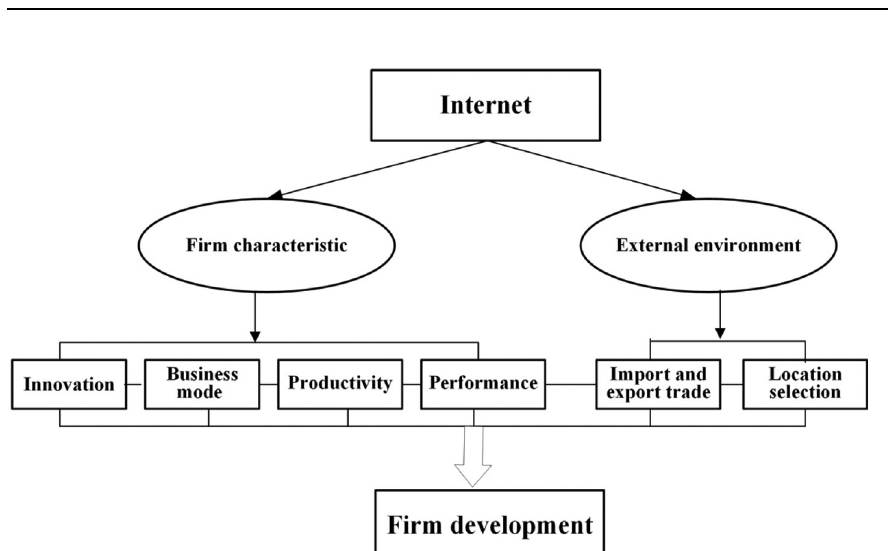
Table VII. Effects of the internet